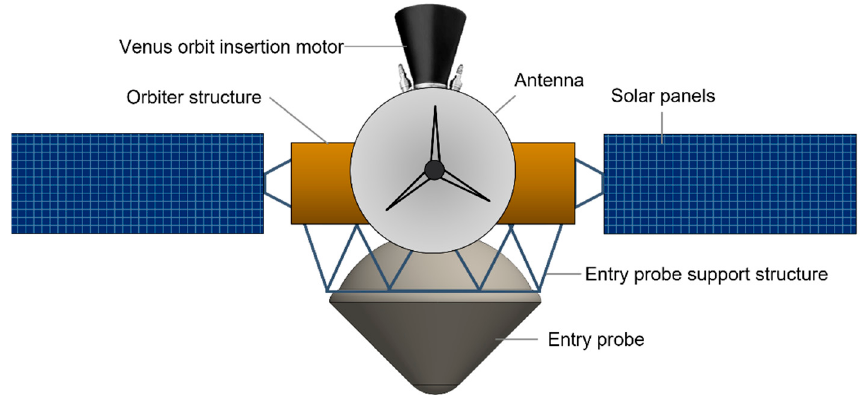
Figure 7. A notional schematic of the orbiter with the probe mounted.